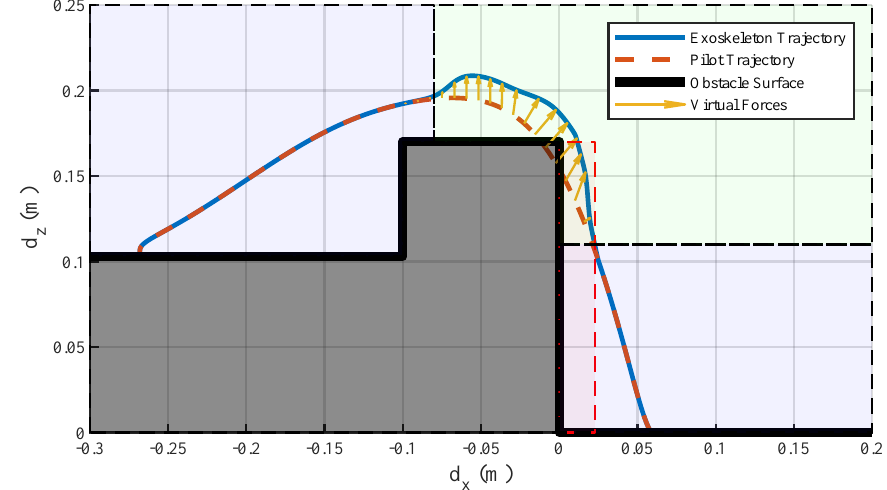
Figure 2. Trajectories of the foot during stepping over the obstacle. The pilot trajectory is a given path that would cause a fall, and the exoskeleton trajectory is the successful obstacle avoidance path after the virtual forces take effect. The short lines with arrows are the resultant forces of the repulsive force and the lifting force generated according to the foot clearance. The trajectory tracking area indicates the exoskeleton following the pilot’s movement. The obstacle avoidance area indicates the exoskeleton regulating the pilot’s movement, and the tripping area indicates a high probability of tripping if no actions are taken during stepping over